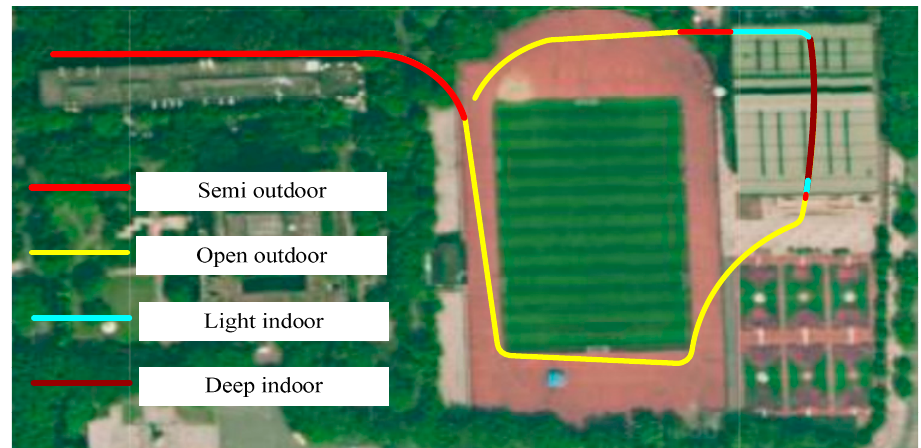
Figure 10. Testing trace located in the university campus. This trace contains two open outdoors segments, three semi-outdoors segments, two light indoors segments, and one deep indoors segment. The volunteer walks along the path in 10 min.